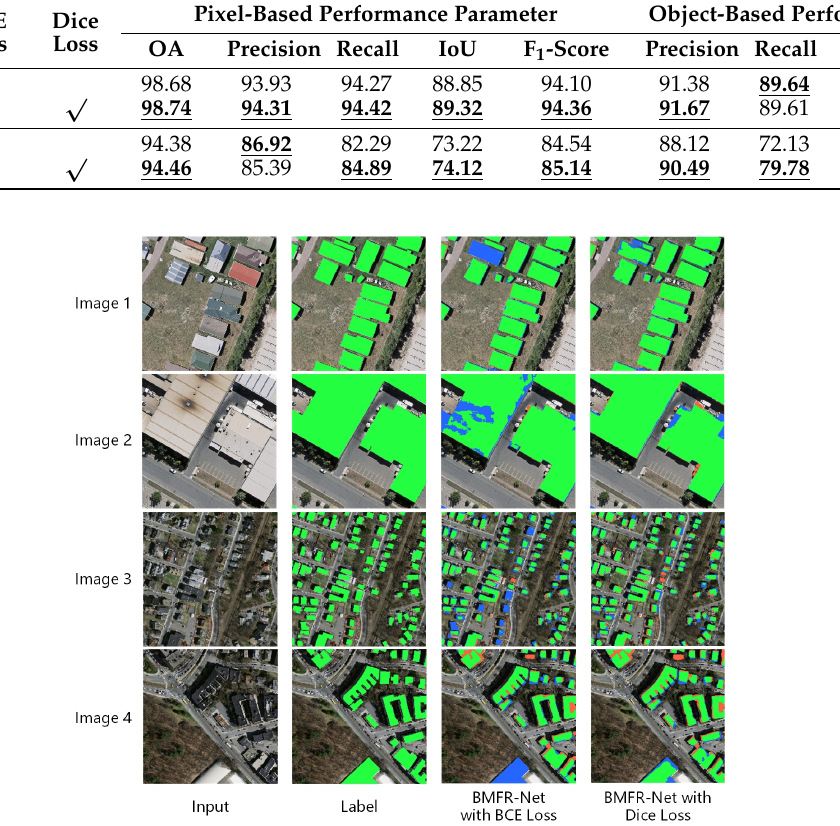
Table 1. Quantitative evaluation (%) of BMFR-Net with different loss functions. The best metric value is highlighted in bold and underline. Datasets